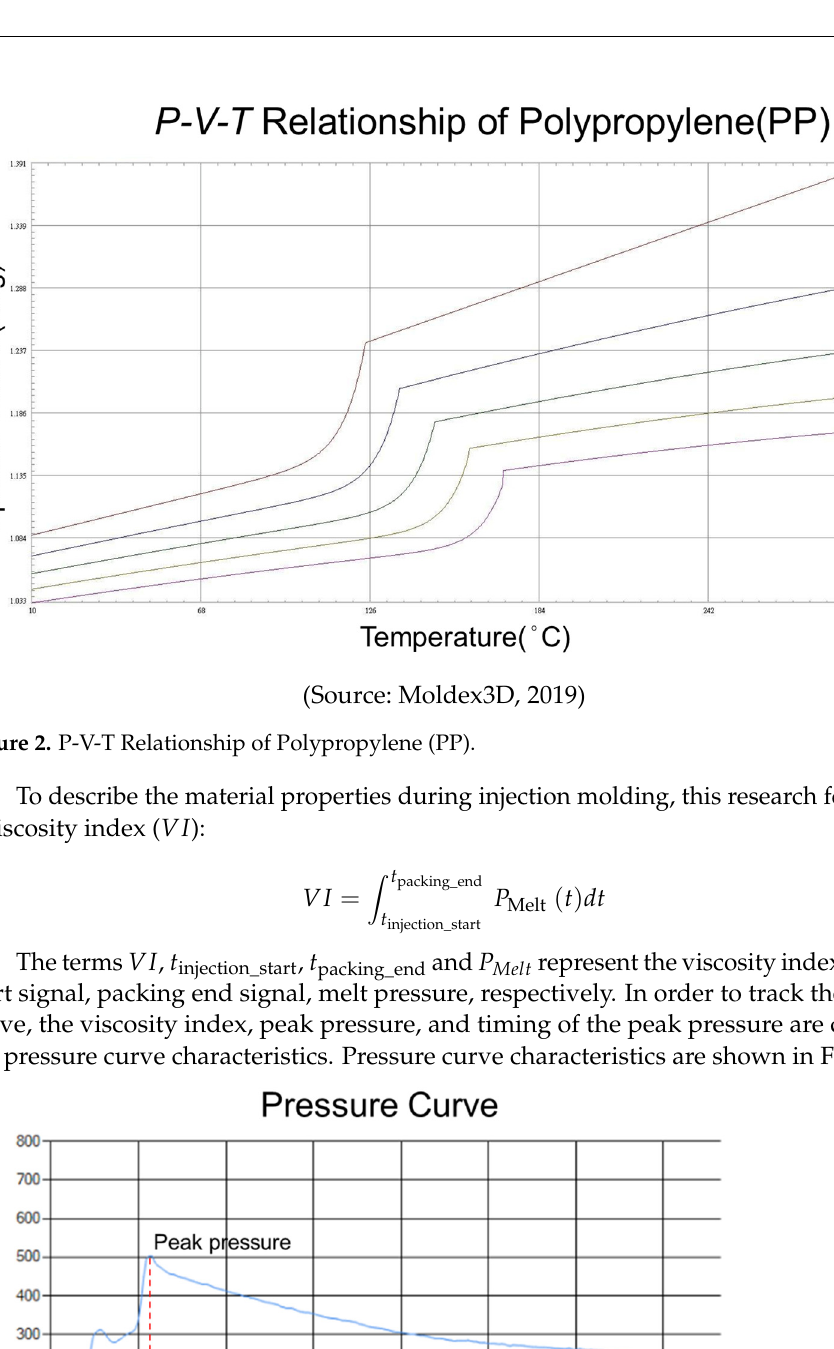
Figure 2. P-V-T Relationship of Polypropylene (PP).